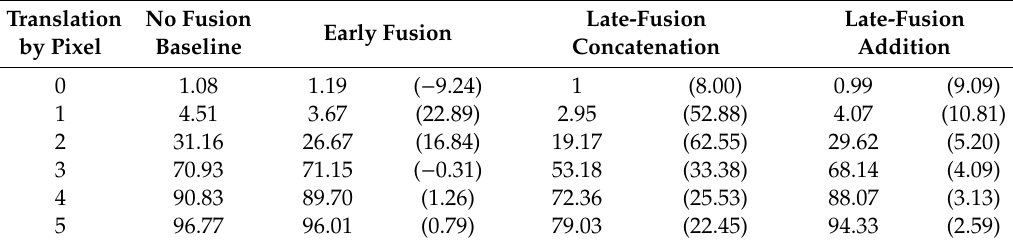
Table 2. Test error rate for a deep network with a small kernel size (Net-8 with 3 × 3 kernel).